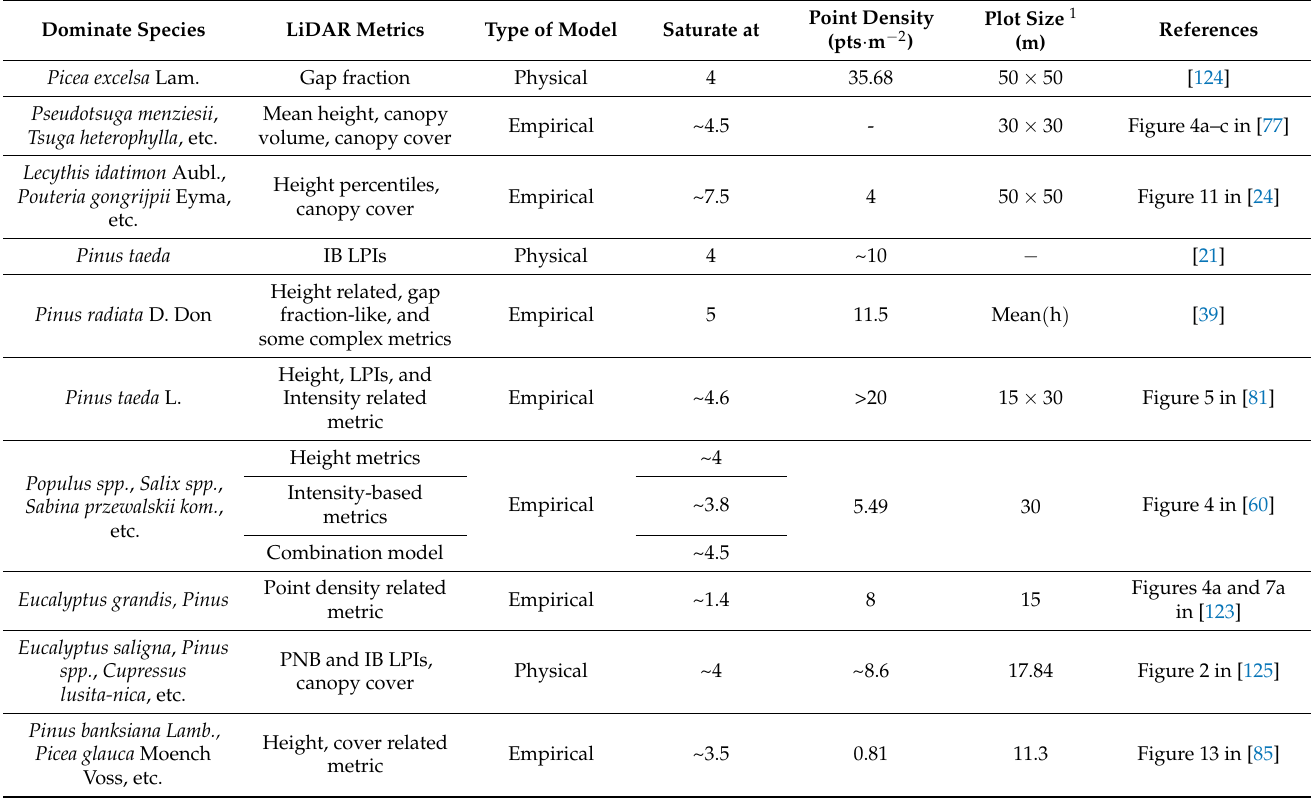
Table 4. Saturation effect of LAI retrieval based on DALS PCD in previous